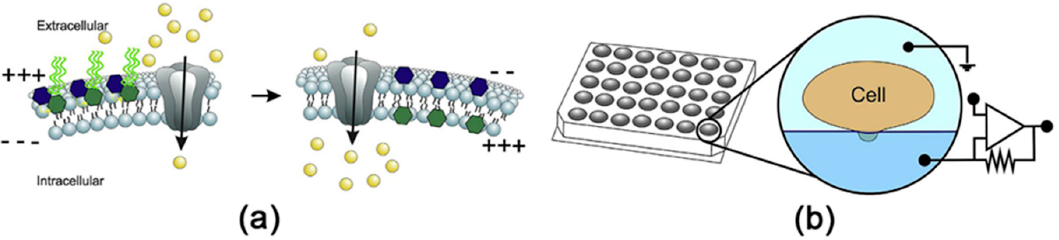
Figure 11. Schematic representation of the patch clamp technique. The bioprocess, which occurs on the interface of the cell membrane due to the action of the pore forming protein and induced the voltage changes (a) . The example of planar patch clamp high-throughput automated electrophysiology platform (b) [247]. Reproduction permission granted by Elsevier.